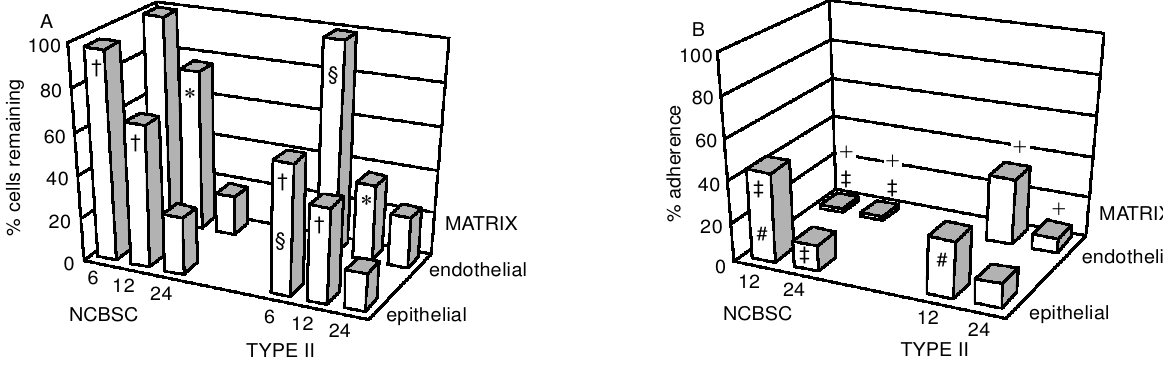
FIG. 3. The effect of 6, 12 and 24 pmol NE on cell detachment from (A), or cell adherence to (B), endothelial matrix and epithelial matrix. (A) = 12 pmol NE/endothelial matrix; NCBSC detachment , type II cells, P , 0 · 001; † = 6 and 12 pmol NE/ epithelial matrix; NCBSC detachment , type II cells, P , 0 · 01; § = 6 pmol NE/type II cell detachment; endothelial matrix , epithelial matrix, P , 0 · 001. (B) ‡ = 12 and 24 pmol NE/NCBSC adherence; endothelial matrix , epithelial matrix, P , 0.001; + = 12 and 24 pmol NE/endothelial matrix: NCBSC adherence , type II cells, P , 0.01; # = 12 pmol NE/epithelial matrix; type II cell adherence , NCBSC, P ,